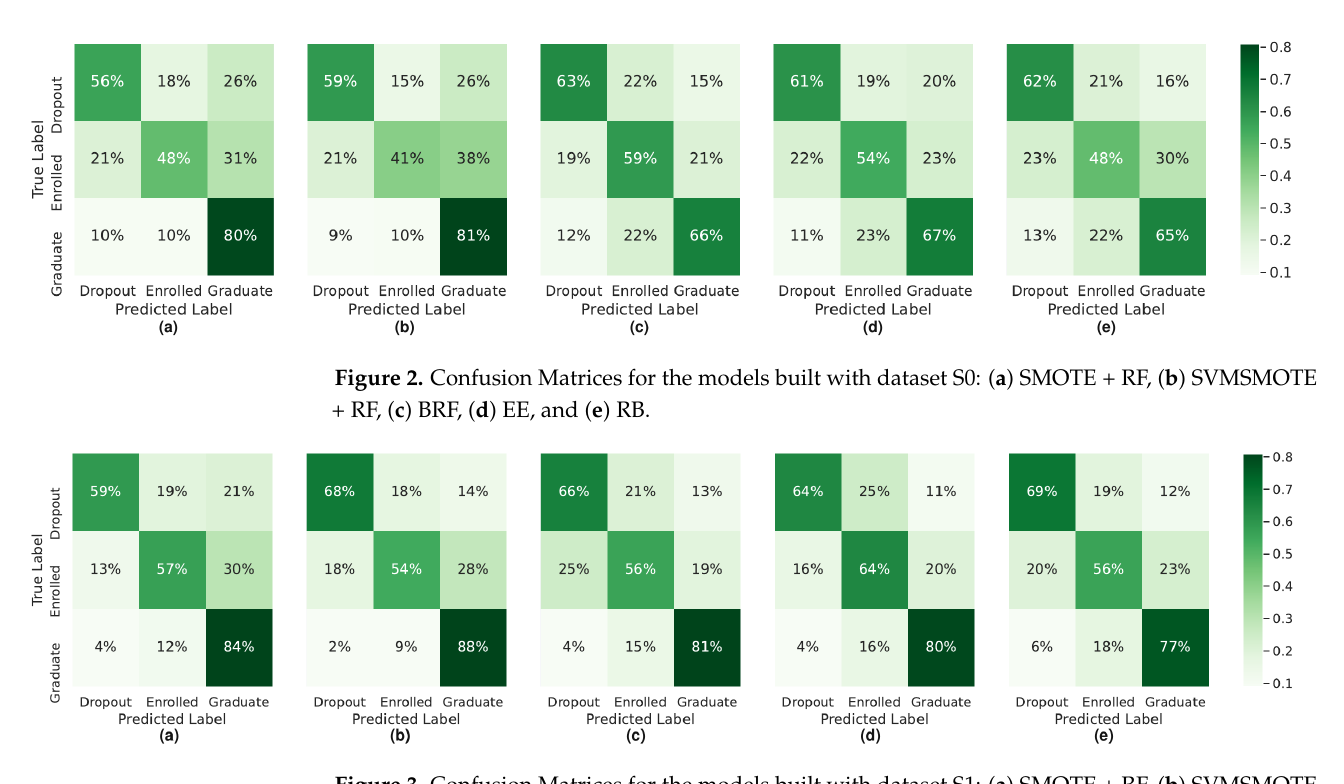
Figure 3. Confusion Matrices for the models built with dataset S1: ( a ) SMOTE + RF, ( b ) SVMSMOTE + RF, ( c ) BRF, ( d ) EE, and ( e ) RB.